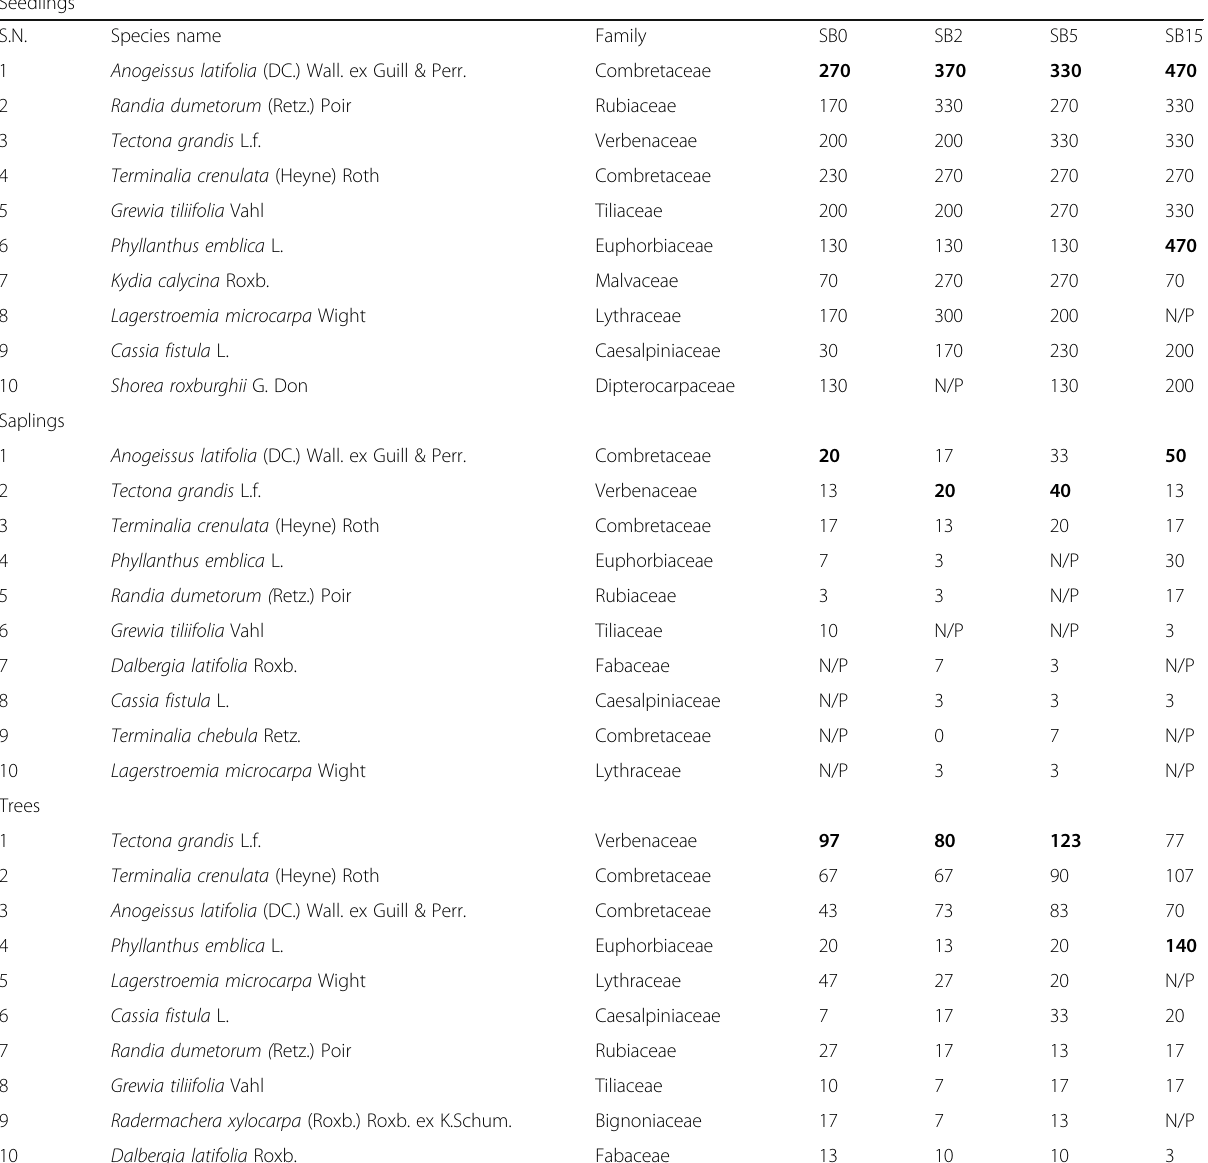
Table 2 Abundance (Individuals ha − 1 ) of top 10 species of seedlings, saplings, and trees Seedlings